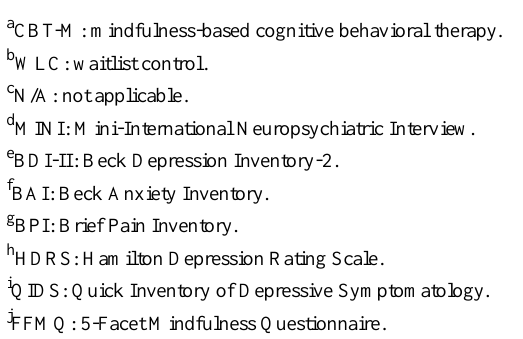
P valueDifference a Final assessment, mean (SD)Pretreatment, mean (SD)Outcome